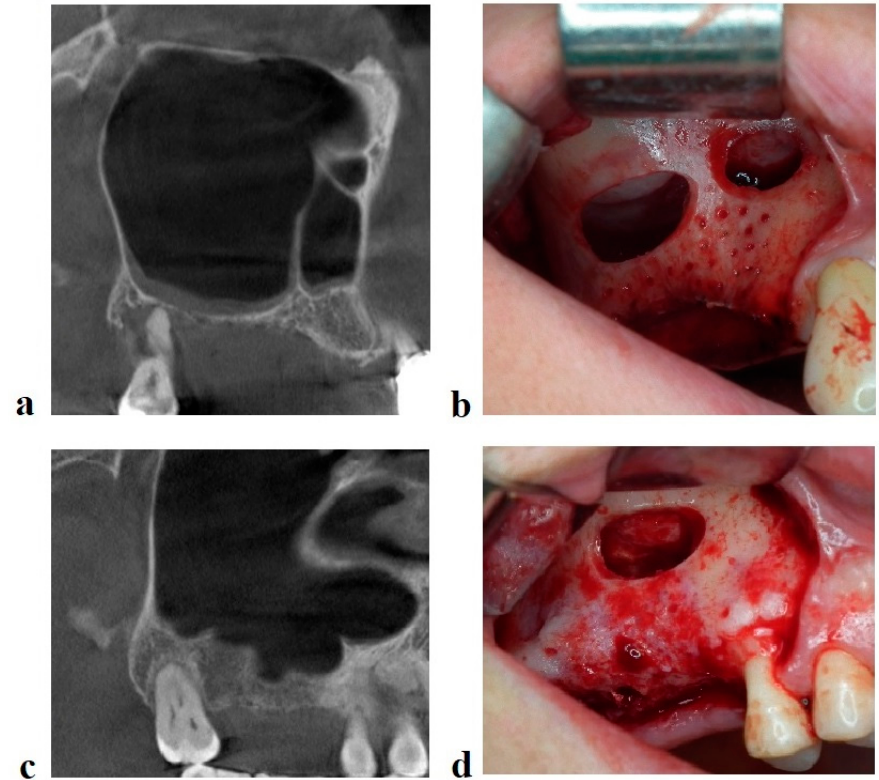
Figure 1. Radiological and clinical aspect of the maxillary sinus in partial edentulous patients before sinus floor augmentation. ( a ) CBCT sagittal view of a right maxilla with a long medio − lateral oriented septum. ( b ) Intraoperative view of the two windows technique. ( c ) CBCT sagittal view of a right maxilla with short medio − lateral oriented septa. ( d ) Intraoperative view of the osteotomy win- dow.